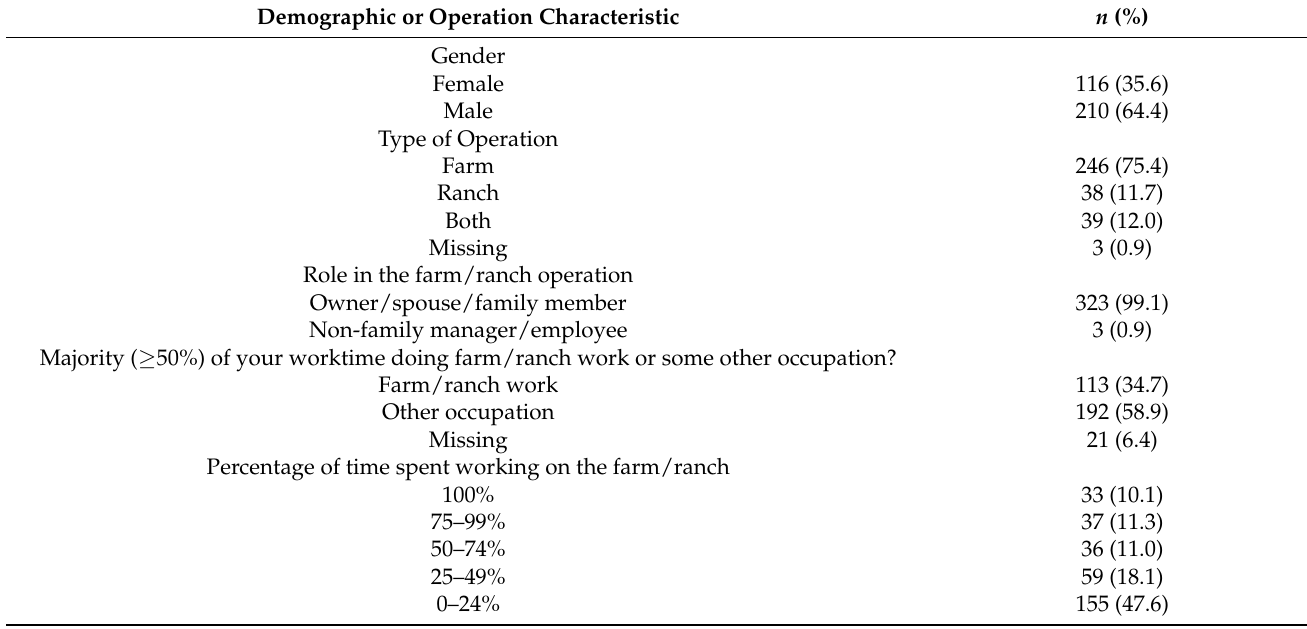
Table 1. Demographic and farm/ranch operator characteristics in 326 respondents from 7 central states in the United States,